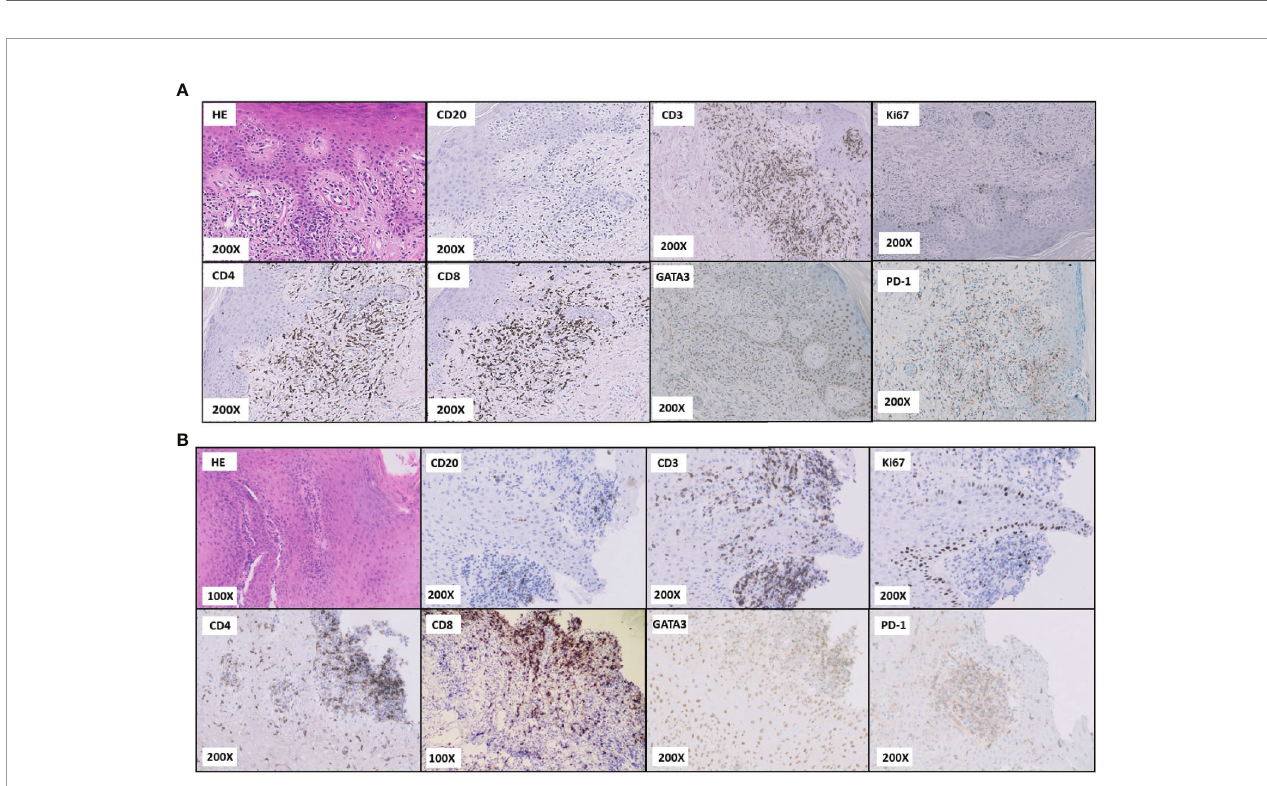
FIGURE 3 | TAMA. HE and immunostaining of the skin (A) and oral mucosa (B) samples in magni fi